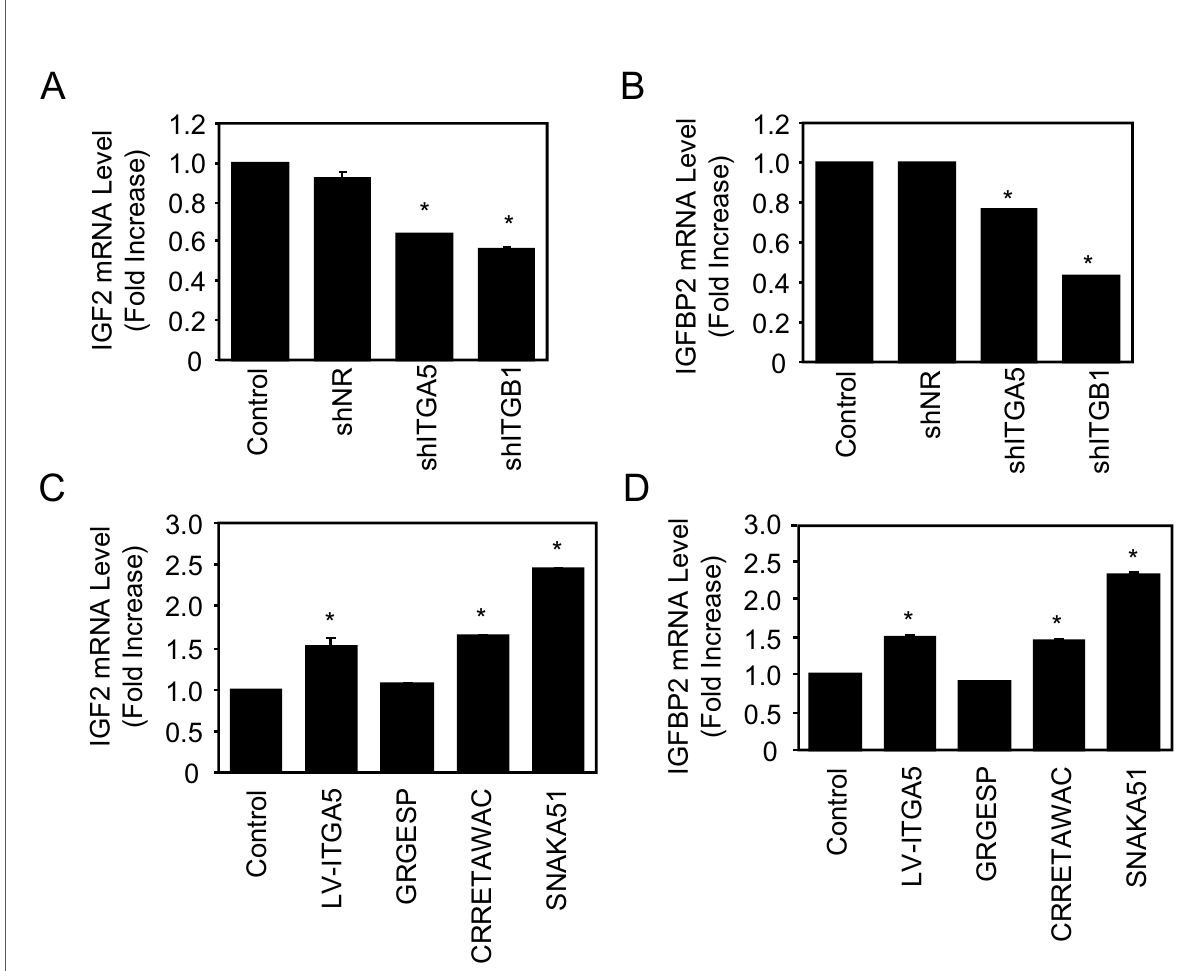
Figure 4 ITGA5 Controls IGF2/IGFBP2 Expression in hMSCs . Adult hMSCs were transduced with shITGA5, shITGB1 or a non relevant shRNA (shNR), total RNA was used for quantitative RT-PCR analysis of IGF2 ( A ) and IGFBP2 ( B ). Adult hMSCs were transduced with a lentiviral vector encoding ITGA5, or treated with the agonist peptide CRRETAWAC (100 μg/ml) (CRRETAWAC) or with a non relevant control peptide (GRGESP; 100 μg/ml), or with a conformation-dependent anti-α5 monoclonal antibody (SNAKA51; 10 μg/ml), and IGF2 and IGFBP2 mRNA expression was determined by quantitative RT-PCR analysis ( C-D ). Results are expressed as mean ± SD of treated over control ratio after normalization to 18 S expression. *: significant difference with untreated cells ( P